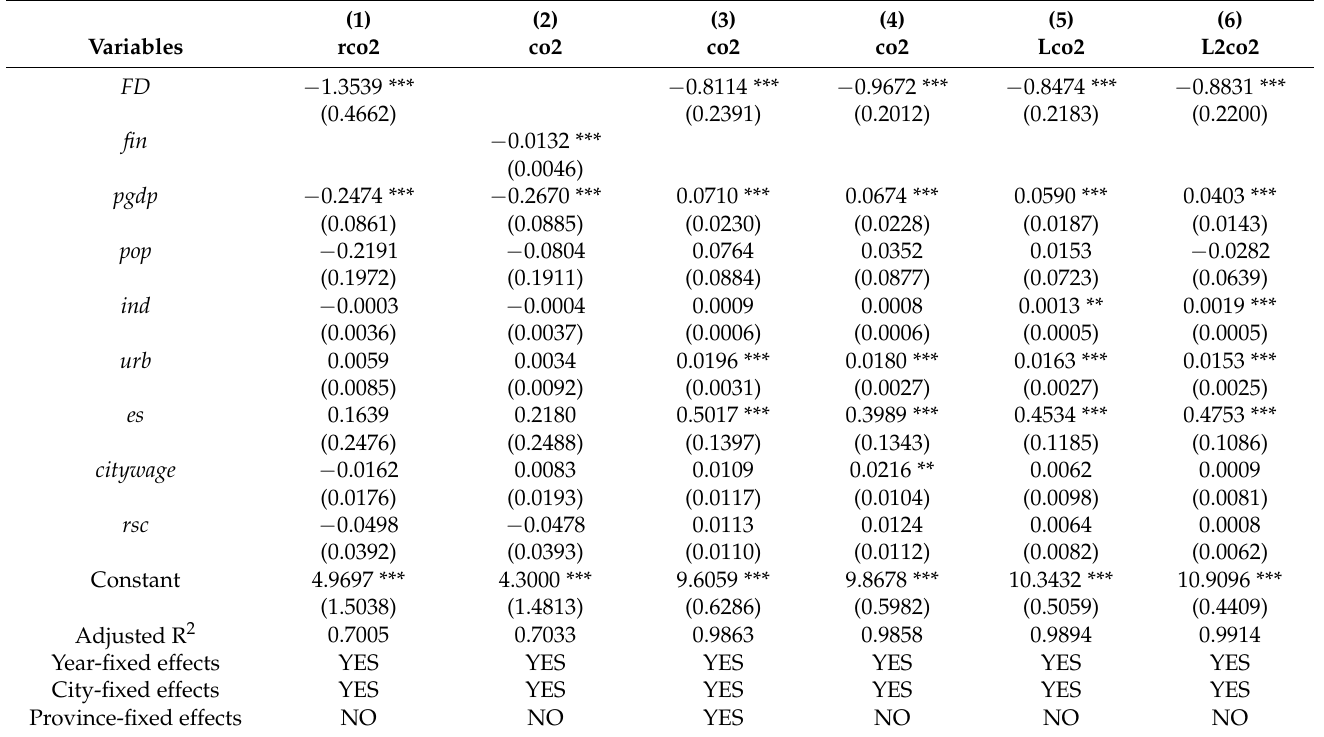
Table 4. Robustness